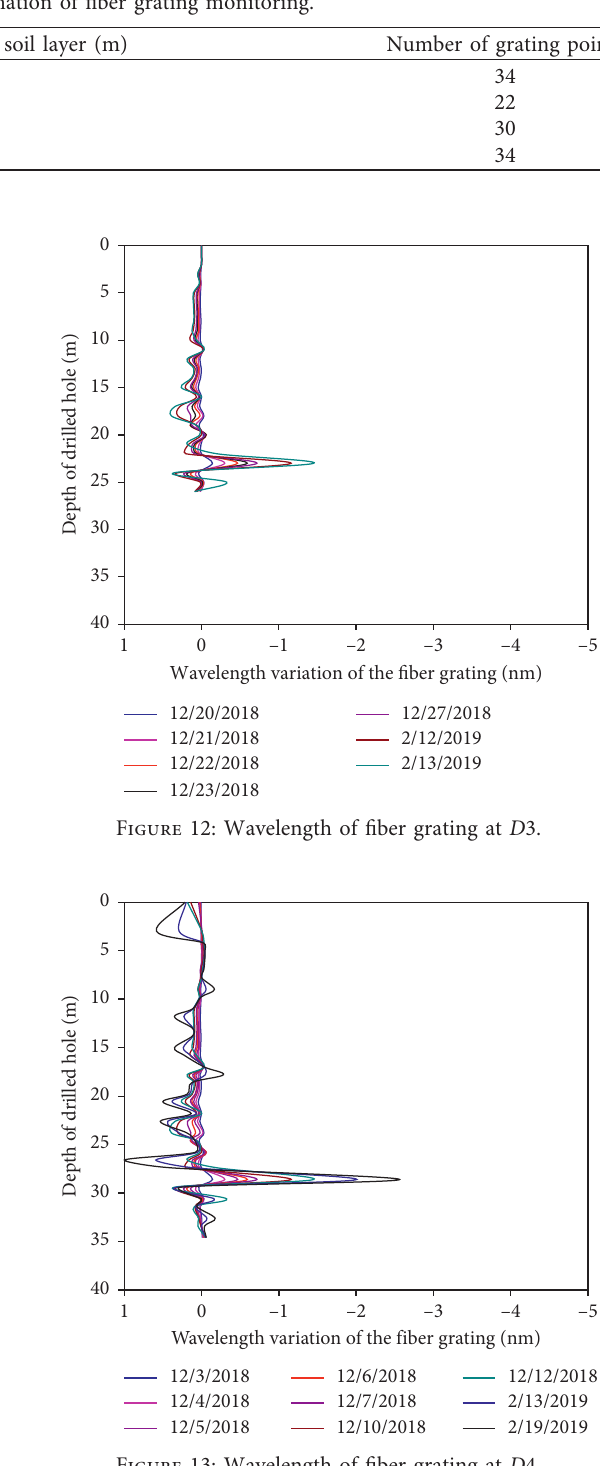
Figure 13: Wavelength of fiber grating at D